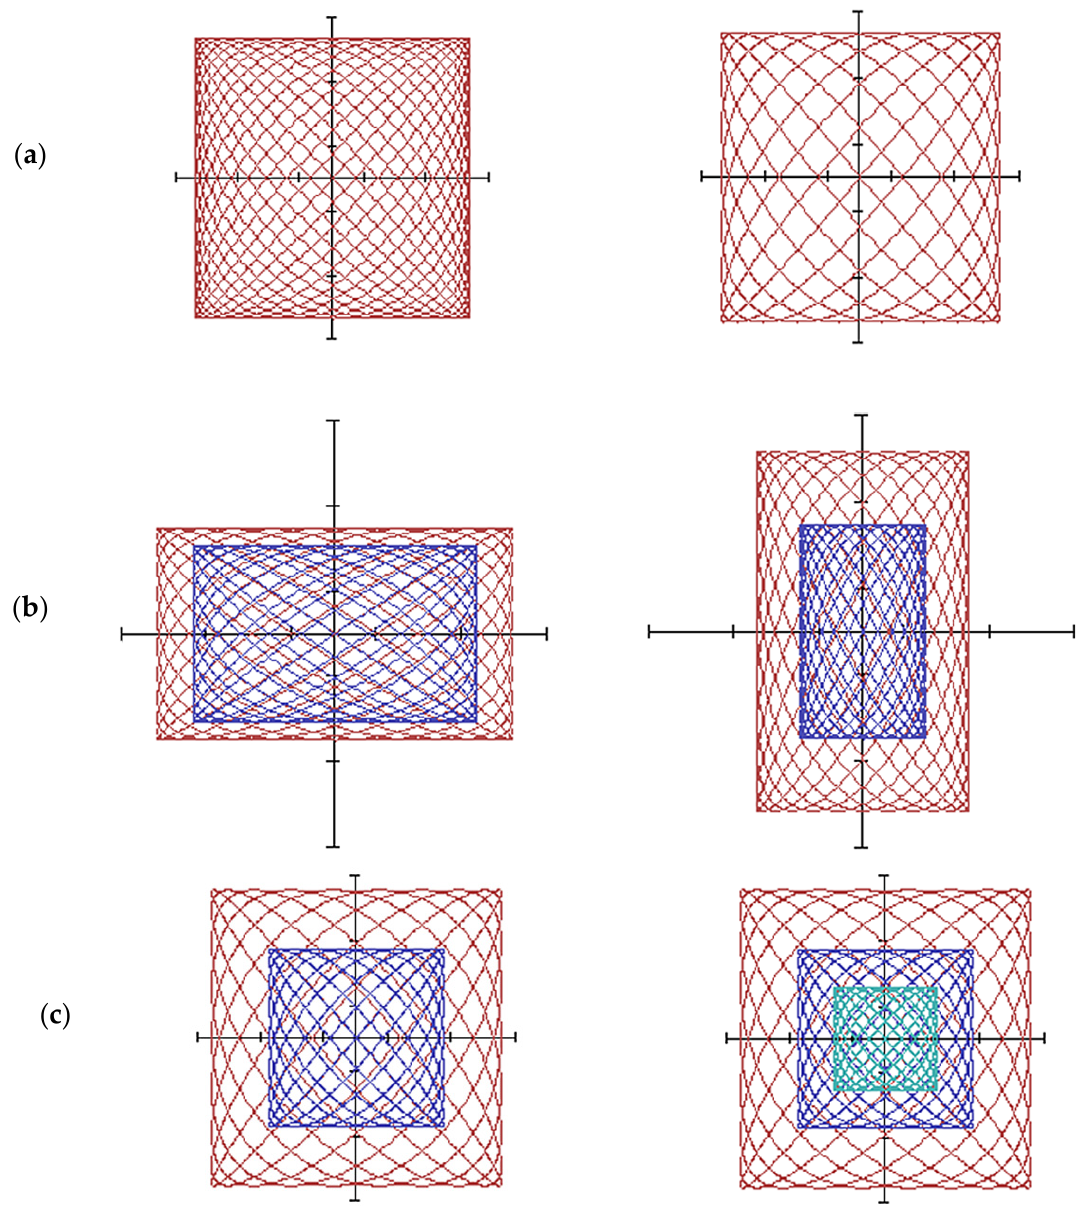
Figure 5. The trajectory of the tool: ( a ) at different ratios of frequencies ω 1 , ω 2 ; ( b ) at different oscillation amplitudes A and B ; ( c ) at different ratios of equal oscillation amplitudes.